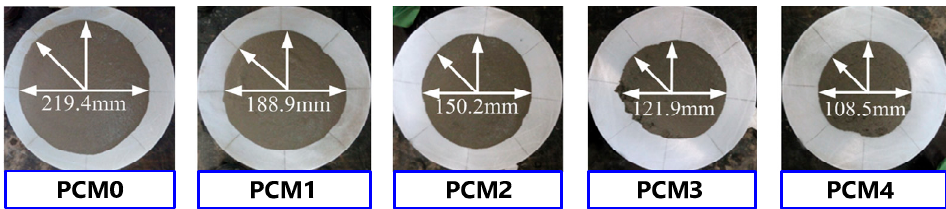
Figure 4. E ff ect of PVA content on the flow spread diameter of fresh mortar Figure 4. Effect of PVA content on the flow spread diameter of fresh mortar mixes.